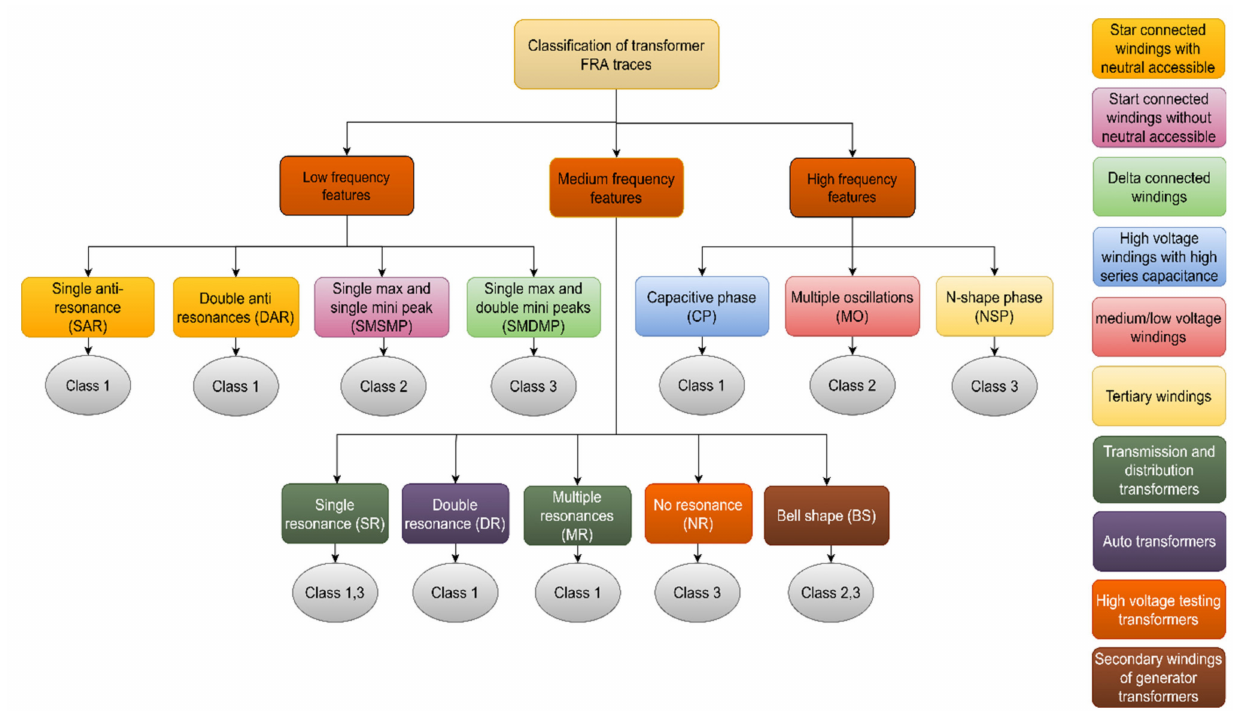
Figure 5. Classification of transformer FRA traces based on different features in the low, medium, and high-frequency